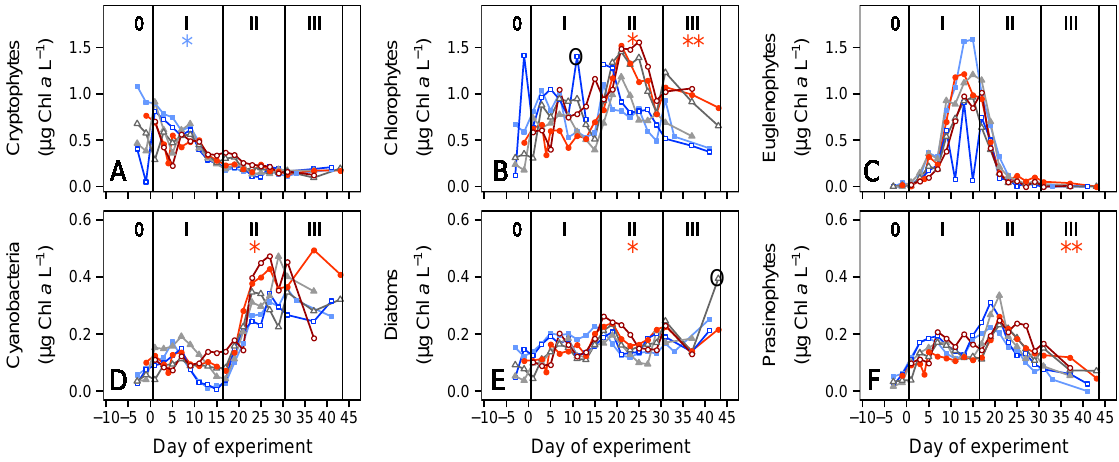
Figure 14. Contribution to total chlorophyll a by different phytoplankton groups as calculated by CHEMTAX from HPLC pigment analyses: (a) cryptophytes, (b) chlorophytes, (c) euglenophytes, (d) cyanobacteria, (e) diatoms, and (f) prasinophytes. Colours and symbols for each CO 2 treatment are described in Table 1. Red asterisks denote significant positive effect and blue asterisk a significant negative effect of CO 2 (* = p <0.05, ** = p <0.01). Outliers are indicated by black circles and were excluded from linear regression analyses.